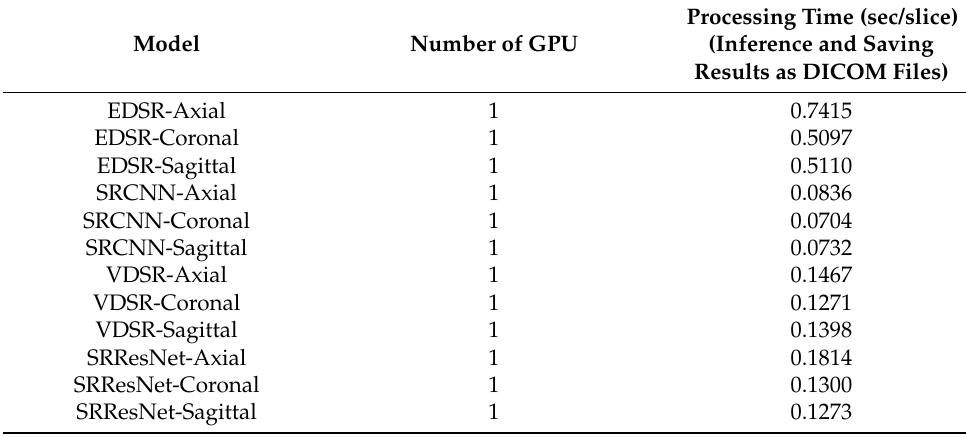
Table 4. Time required to generate each SR DICOM